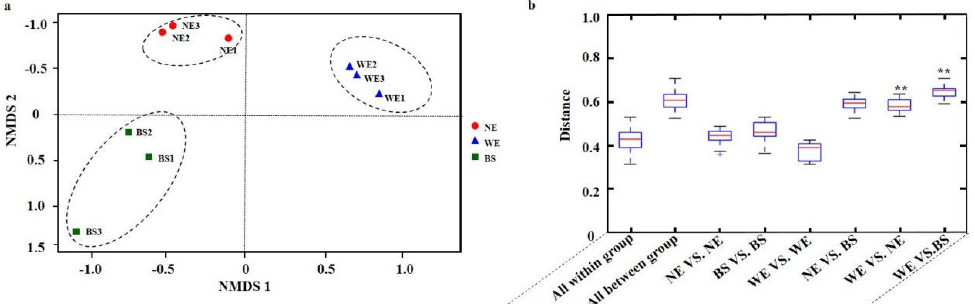
Figure 3. Analysis of fungal–community structures of soil samples. ( a ) Non metric multidimensional scaling (meta NMDS; stress: 0.042) based on BrayCurtis dissimilarity among fungal communities of OTUs that occurred on three sites; NE refers to soil not inoculated with ectomycorrhizal fungi, WE refers to soil inoculated with ectomycorrhizal fungi, and BS refers to bulk soil. ( b ) Boxplot of inter–group and intra–group differences, based on weighted UniFrac distance matrix on soil fungal community under different treatments. ** p < 0.01.